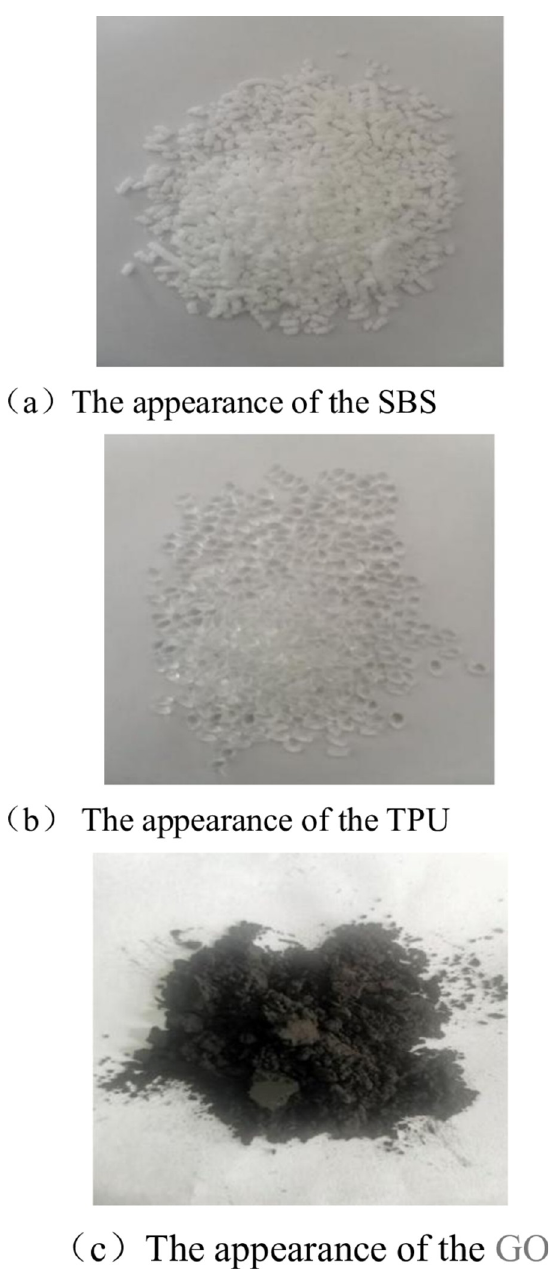
Fig 1. The appearance of the modifiers used in this research. The appearance of the SBS ( a ), TPU ( b ), and GO ( c